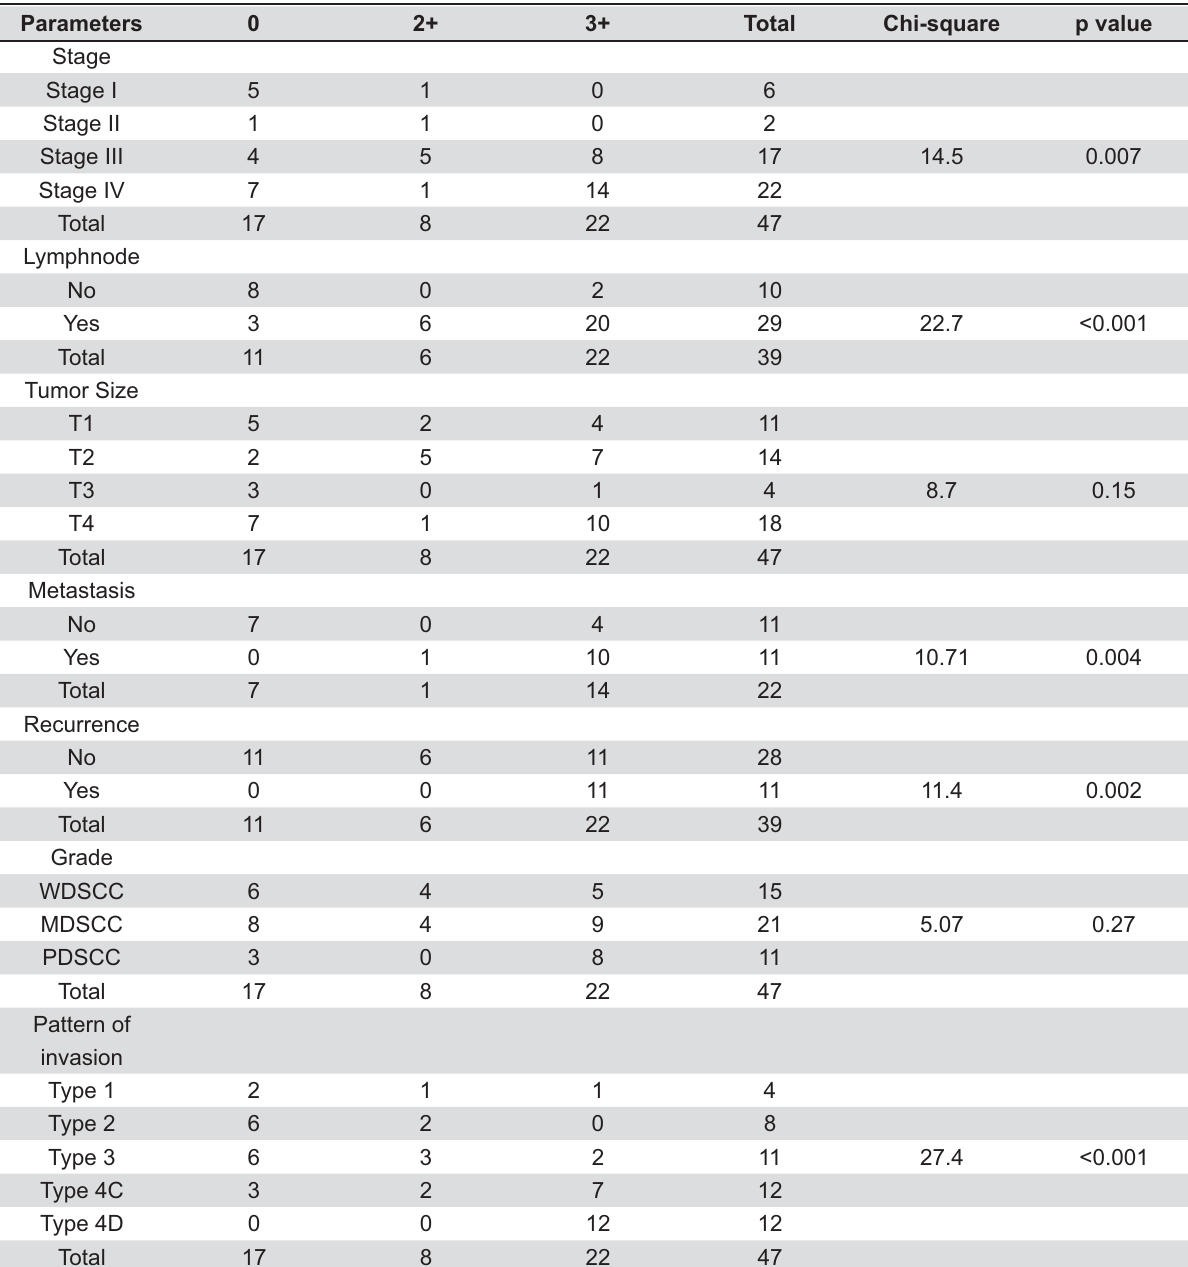
Table 2- Association of S100A4 expression with clinical stage, lymph node involvement, tumor size, metastasis, recurrence, grade of tumor and pattern of